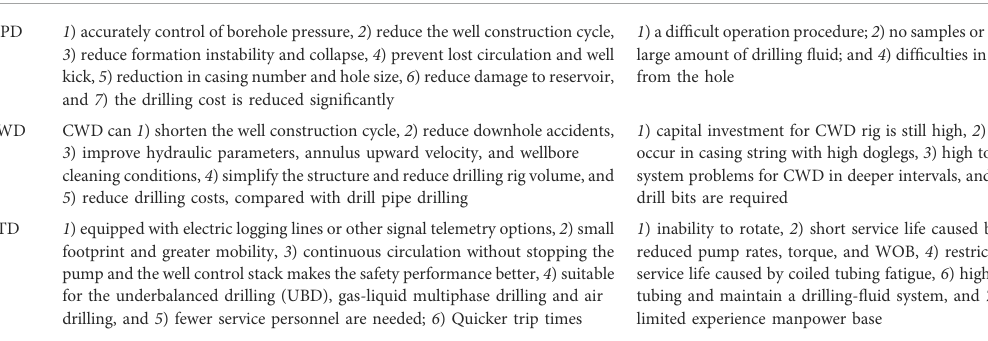
TABLE 2 Characteristics of drilling technologies suitable for gas hydrate exploration and